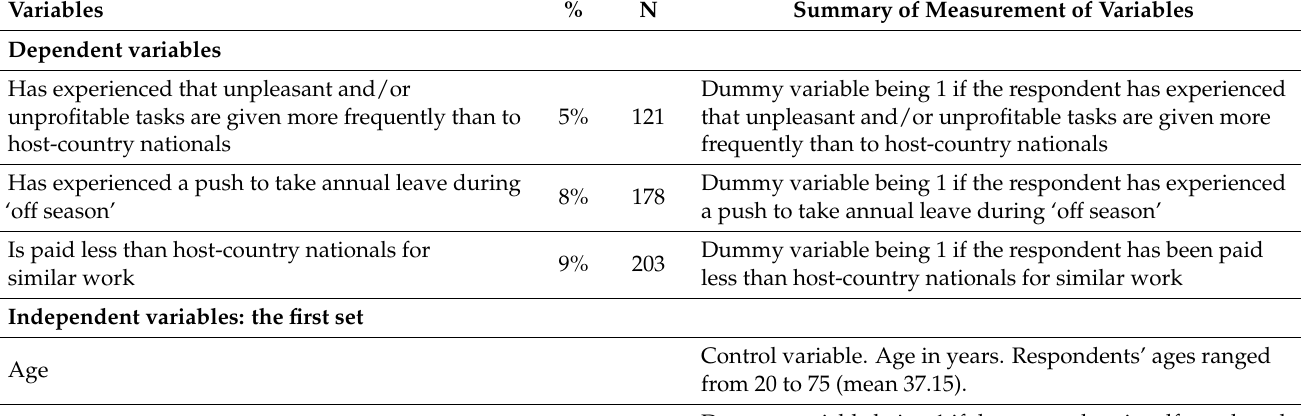
Table 2. Descriptive statistics of the dependent and independent variables (N = 2332) and a summary of measurement of